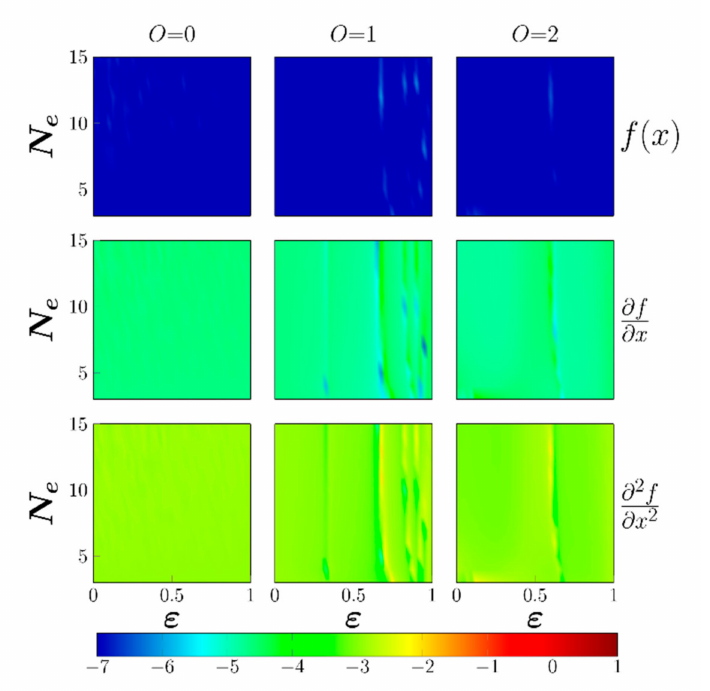
Figure 6. The log10 of the norm of the error of approximating the given function f ( x ) and its first two derivatives using Gaussian RBF-TPU with different truncation orders for a range of ε and N e values. The rows are for function, first derivative, and second derivative approximation, while the columns are for zeroth, first, and second orders of truncation. ε k ranges between [0, 1] and m =